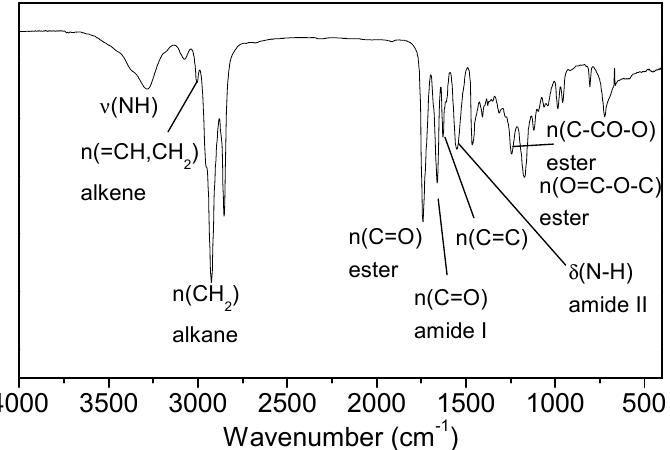
Figure 7. FTIR spectrum of the olive oil-based monomer. Adapted with permission from [12]. Copyright (2016) American Chemical Society.